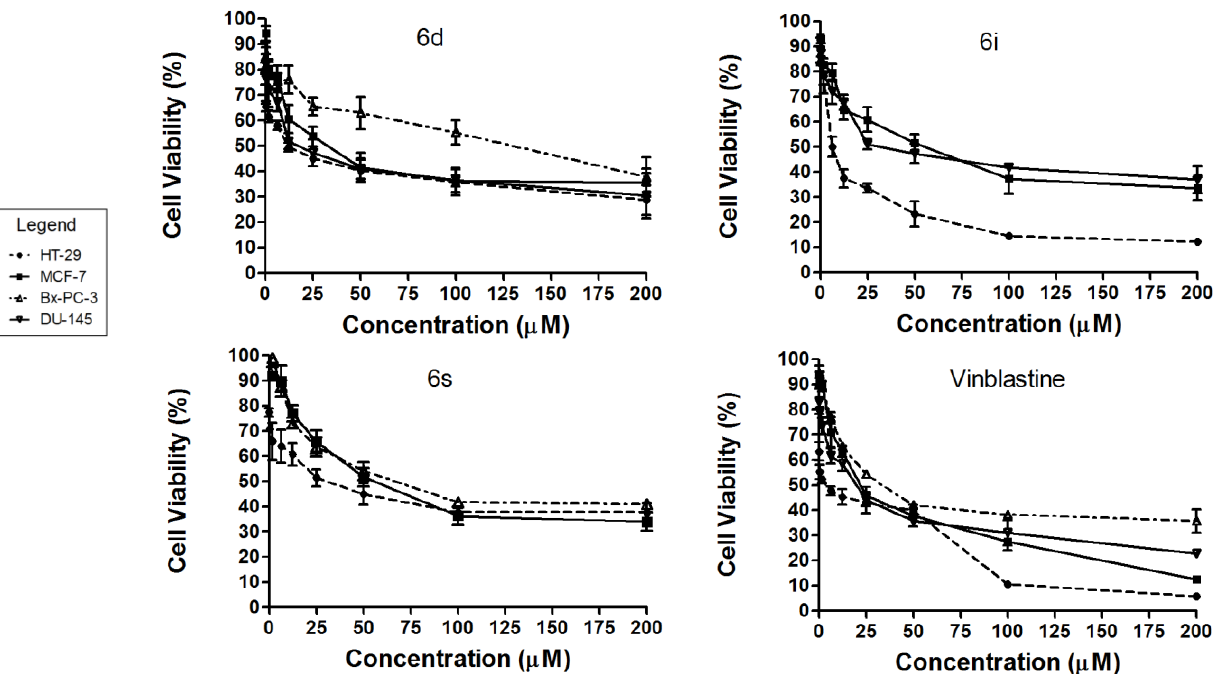
Figure 1. Dose-response curves of selected o -carboxamido stilbenes on human cancer cell